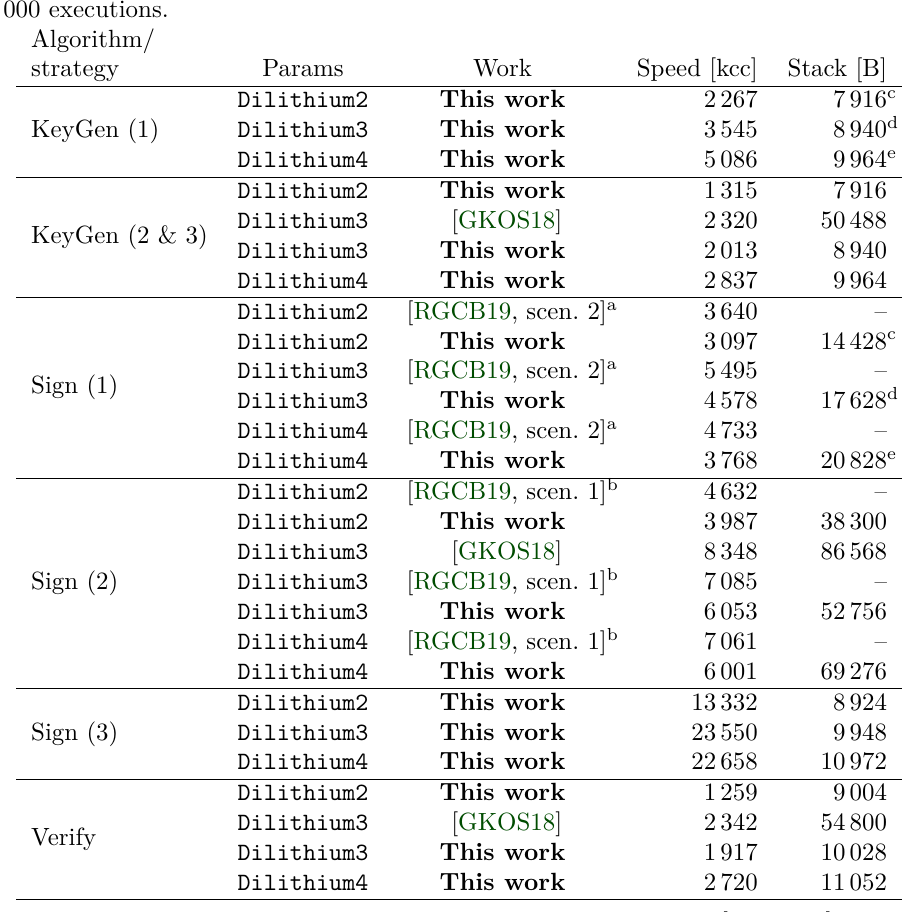
Table 3: Performance results on the Cortex-M4 (STM32F407 at 24 MHz). Averaged over 10 000